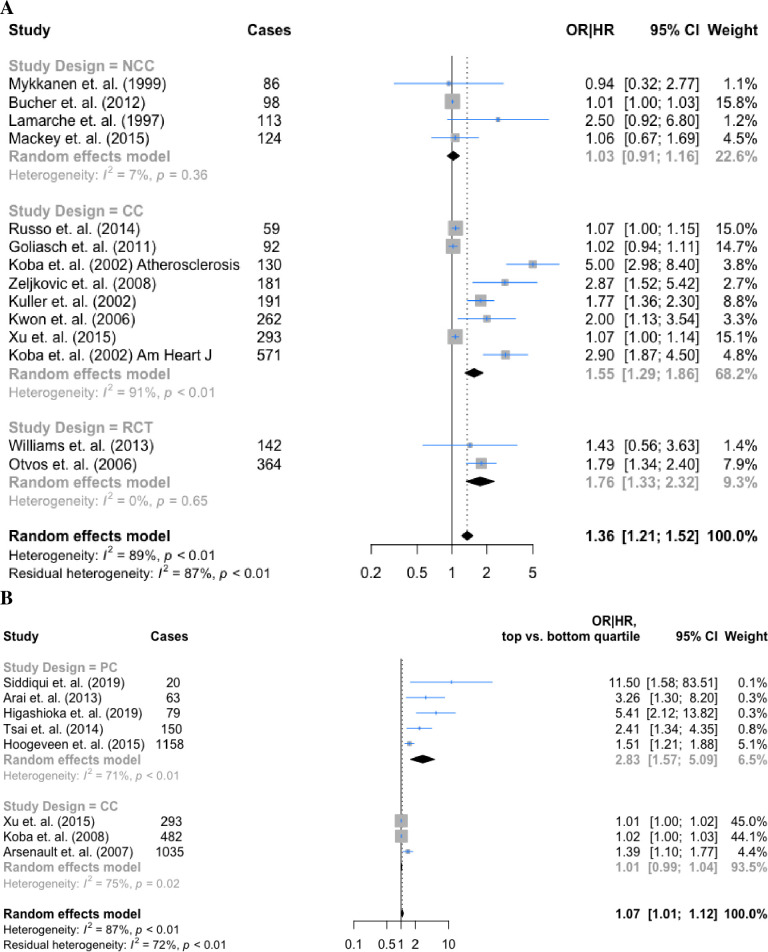
Forest plots of association between (A) sdLDL, (B) sdLDL-C and CHD subgrouped by study design. PC = prospective cohort study; CC = case-control study; NCC = nested case-control study; RCT = randomized controlled trial.